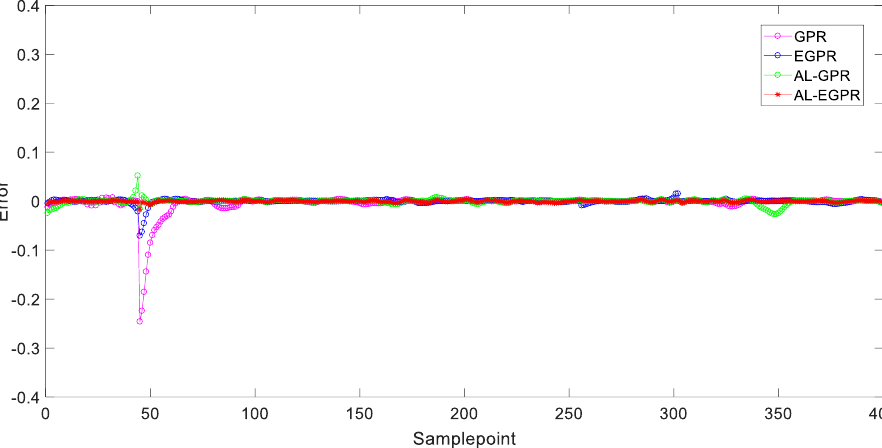
Figure 14. Prediction error of test samples for four different soft sensors after the 7 th iteration.